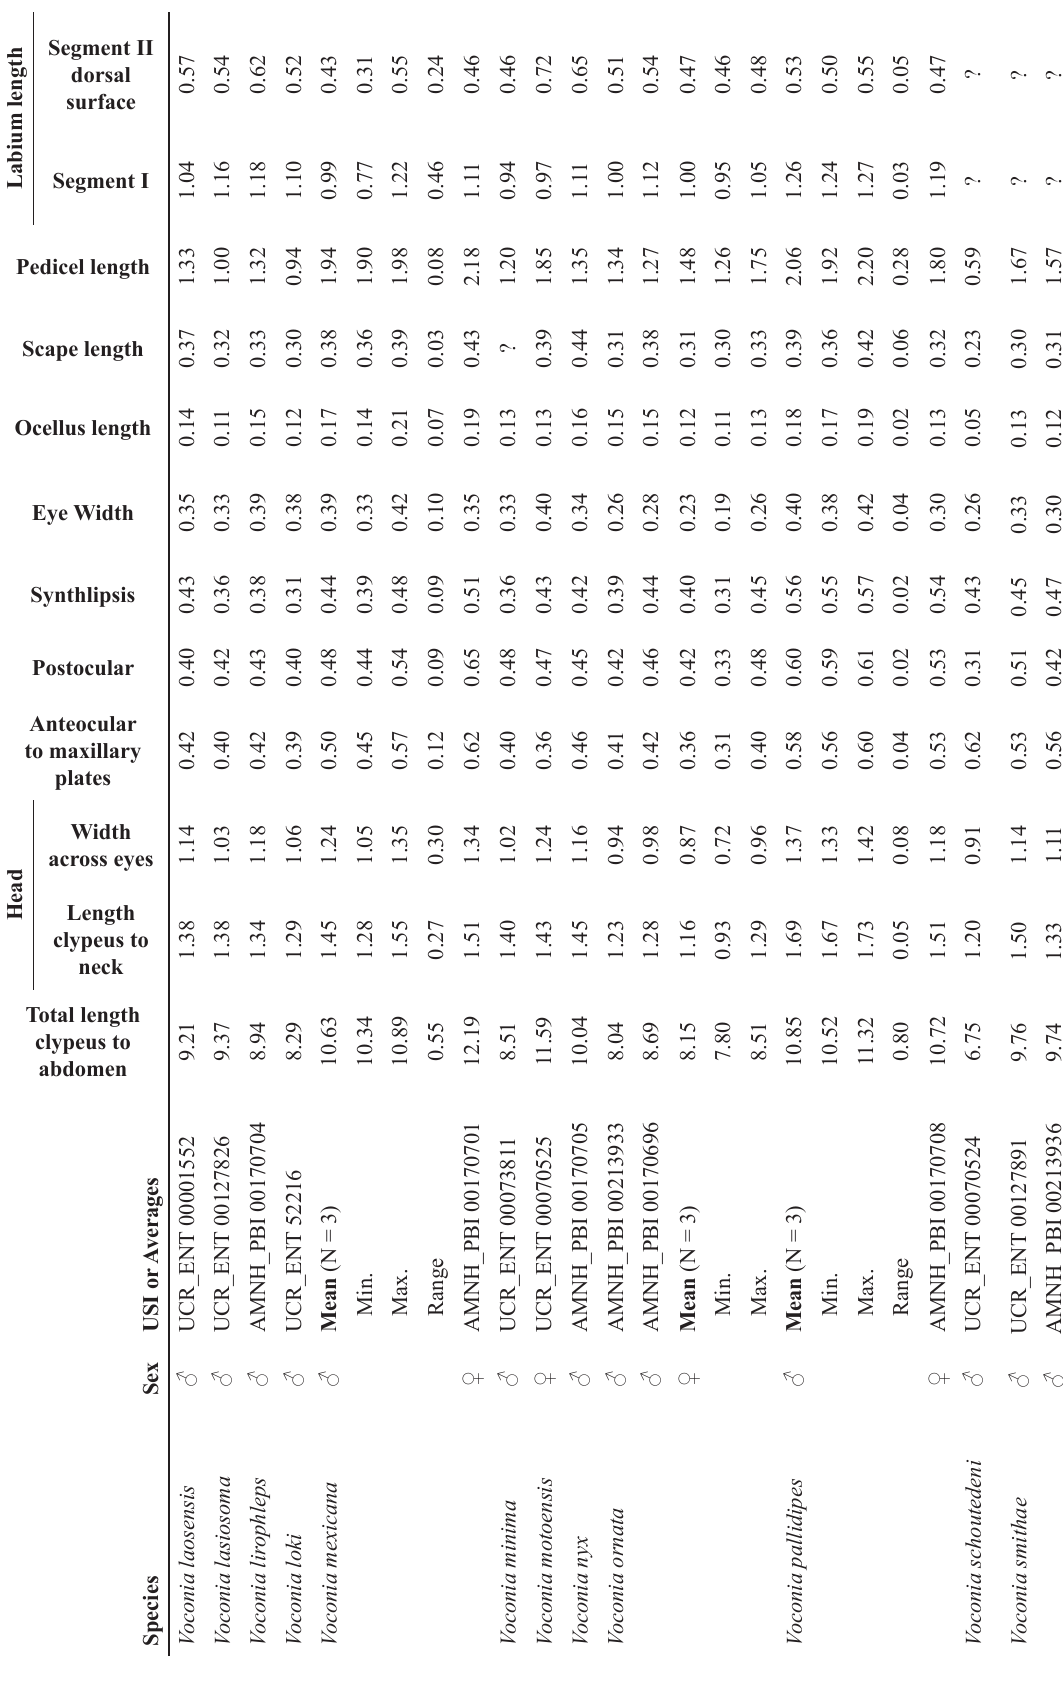
lengthScape WidthOcellus Eye Synthlipsis platesPostocular Anteocular to maxillary neckWidth across d a H e Length clypeus to Total length clypeus to abdomen